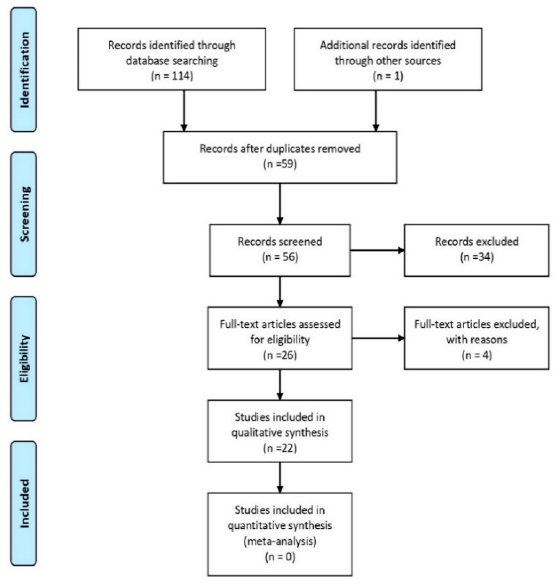
Figure 1. Flow chart of studies included in the review.